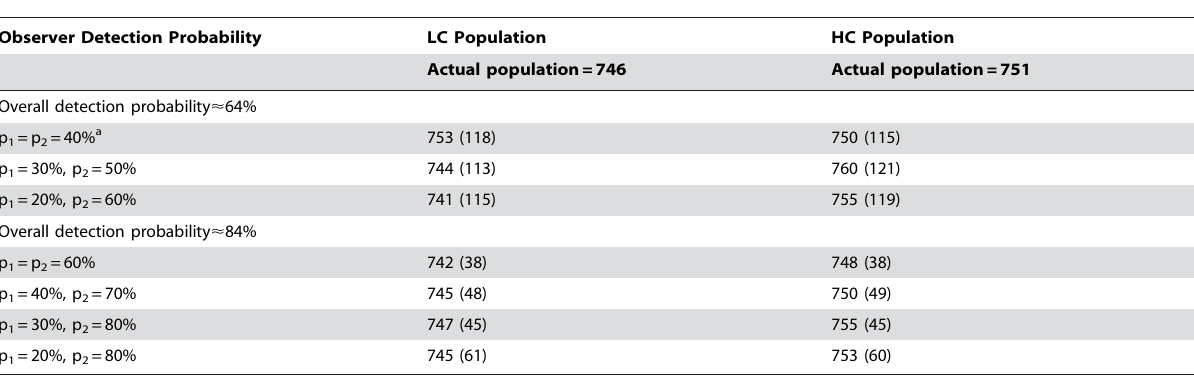
Table 1. Median population estimates (SD) for the double observer method.